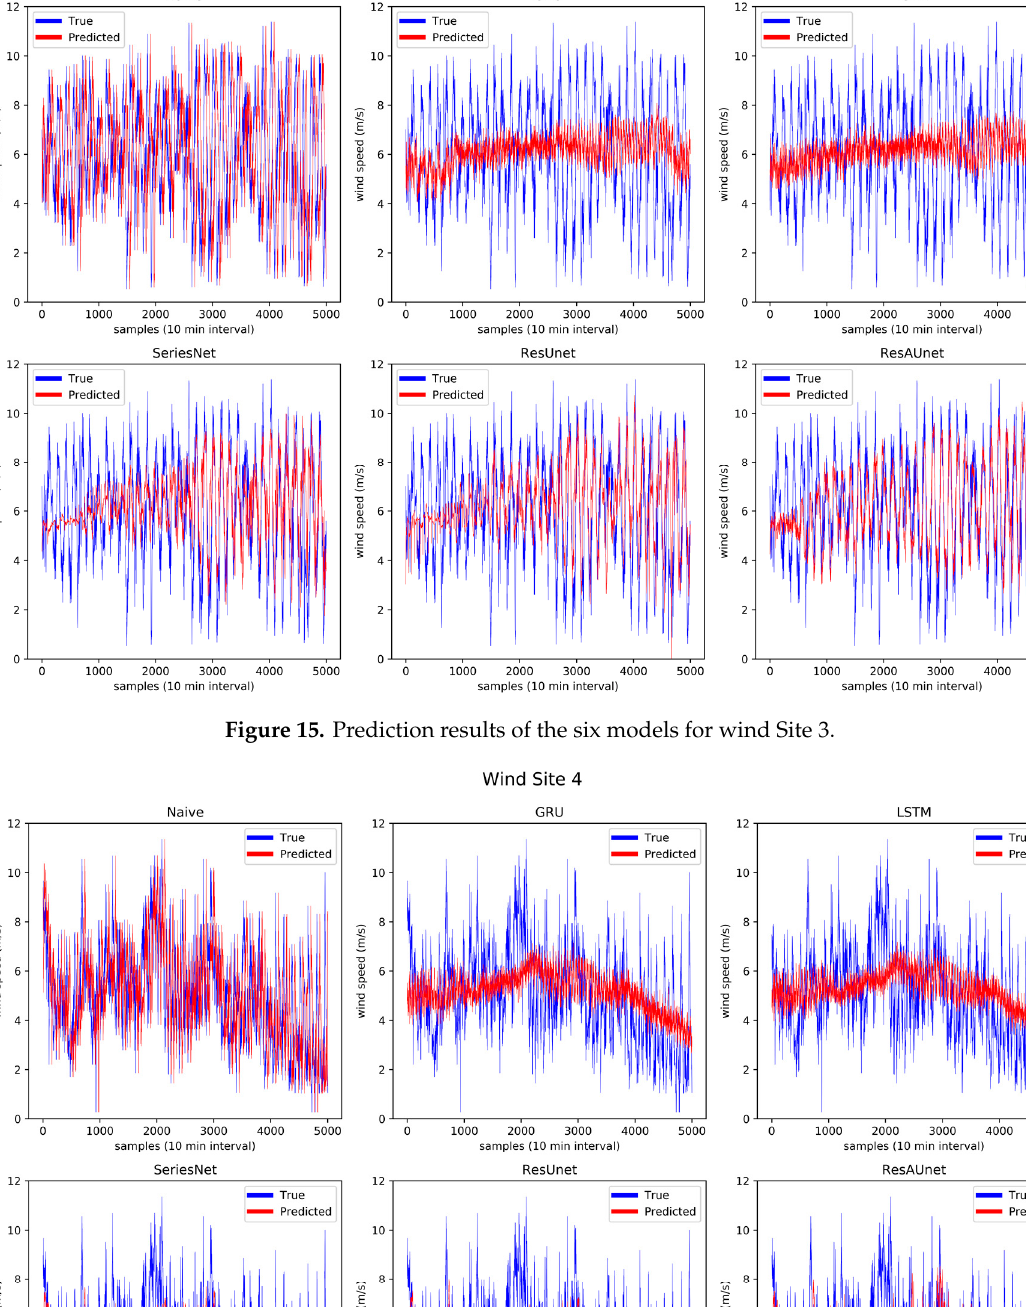
Figure 14. Prediction results of the six models for wind Site 2.